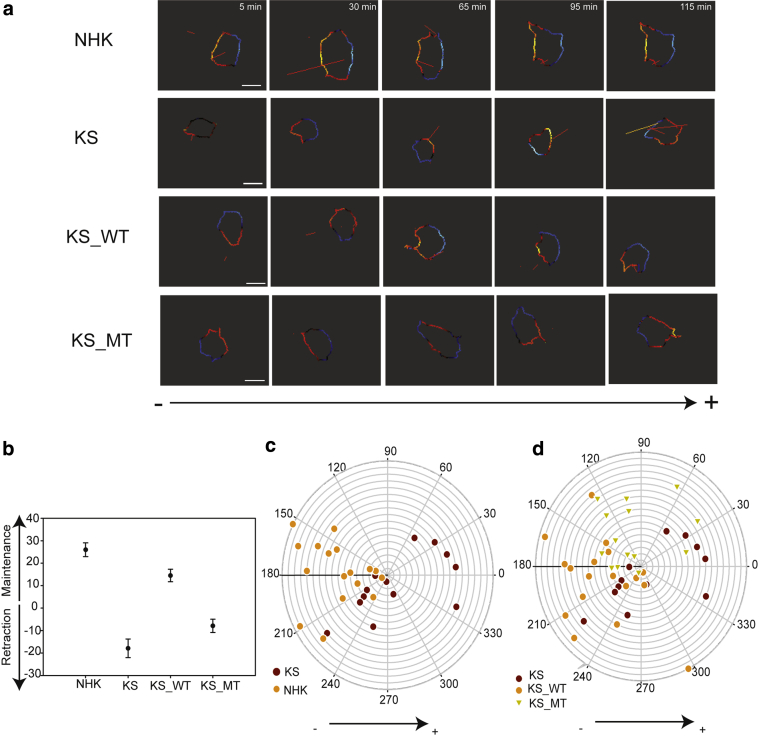
Kindlin-1 is important for the maintenance and distribution of EF-induced protrusions. Pseudopod maintenance and retraction during electrotaxis were analyzed using the Quimp algorithm. (a) Representative images show pseudopod dynamics in NHK, KS, KS_WT, and KS_MT treated with 200 mV/mm for 1 hour (see Supplementary Video S4). Red indicates protrusion maintenance, and blue indicates membrane retraction. (b) The maintenance and retraction scores of a pseudopod according to its contribution to cell body transition in previous and after image frame. The graph shows pseudopod scores of NHK, KS, KS_WT, and KS_MT in electrotaxis. Minus indicates retraction, and positive indicates maintenance. (c, d) Pseudopod distribution of (c) NHK and KS or (d) KS, KS_WT, and KS_MT cells. The EF vector is horizontal, with cathode to the left. Scale bar = 50 μm. KS, Kindler syndrome; KS_MT, kindlin-1–mCherryW612A point mutation; KS_WT, Kindler syndrome cells infected with wild-type kindlin-1–mCherry; NHK, normal human keratinocyte.